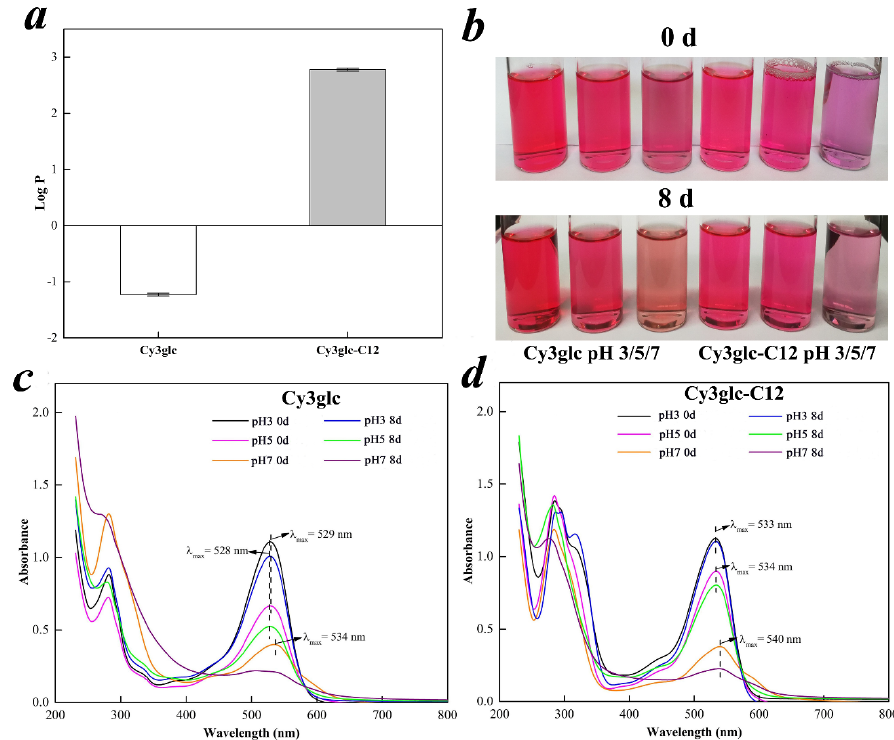
Figure 4. Lipophilic property ( a ), color feature ( b ), and UV-VIS absorbance property of Cy3glc and Cy3glc-C12 ( c and d ) during storage for eight days in the dark at pH 3, 5, and